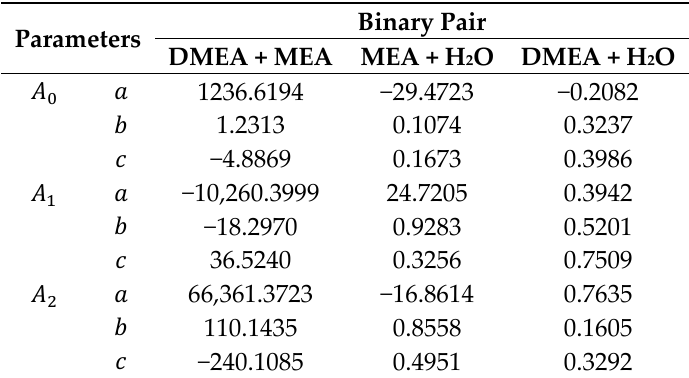
Table 8. Binary parameters 𝐴 0 , 𝐴 1 , and 𝐴 2 of the equation 𝑉 𝑗𝑘𝐸 = 𝑥 𝑗 𝑥 𝑘 ∑